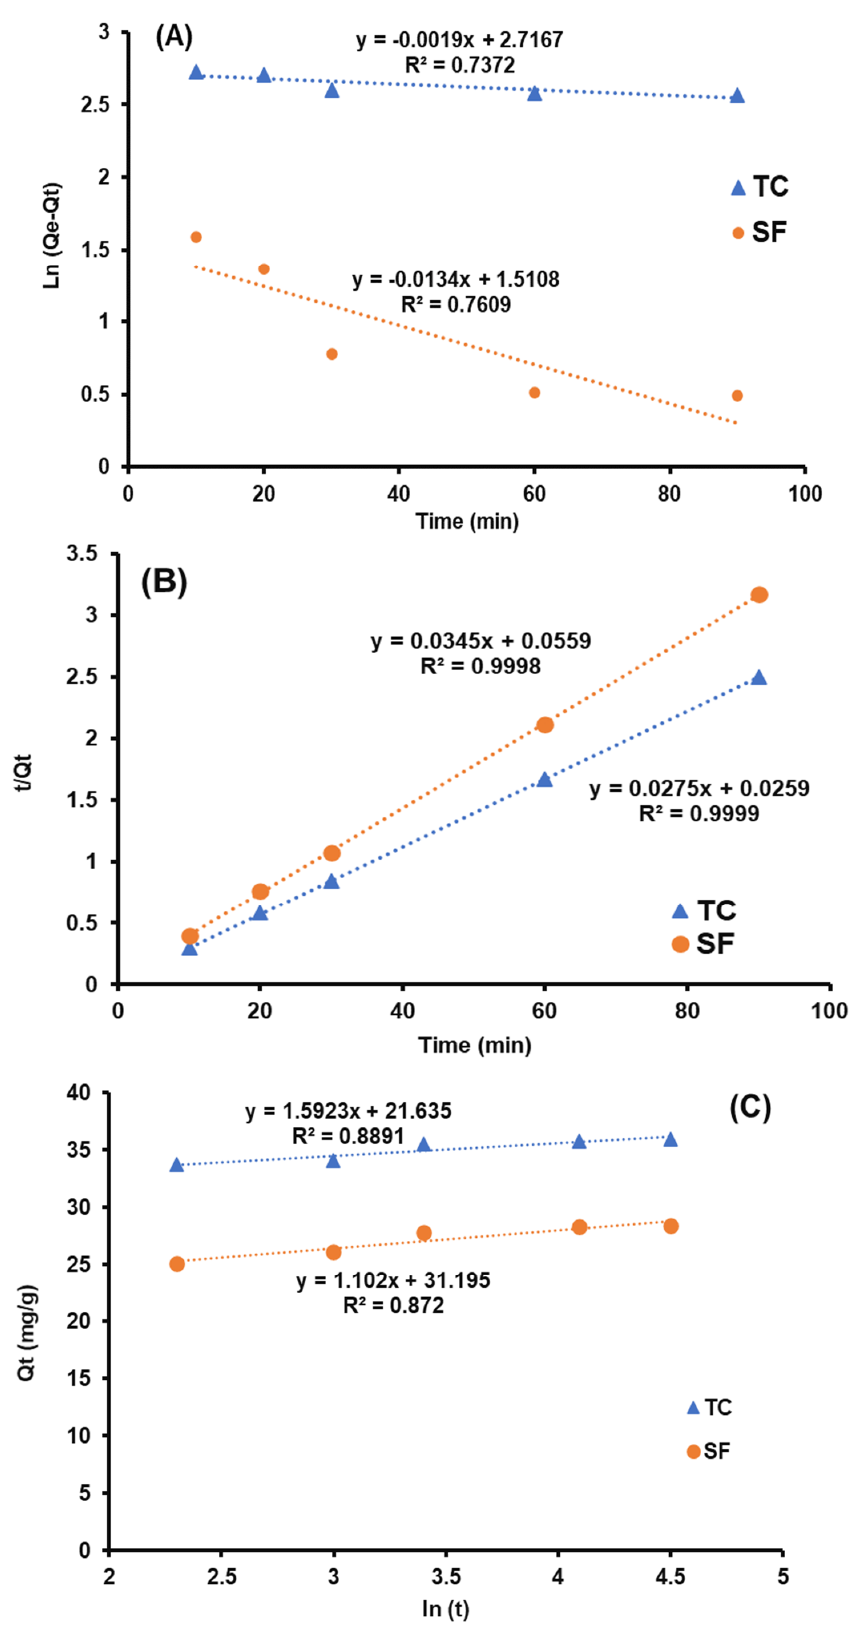
Figure 8. Pseudo-first-order ( A ), pseudo-second-order ( B ), and Elovich ( C ) linear